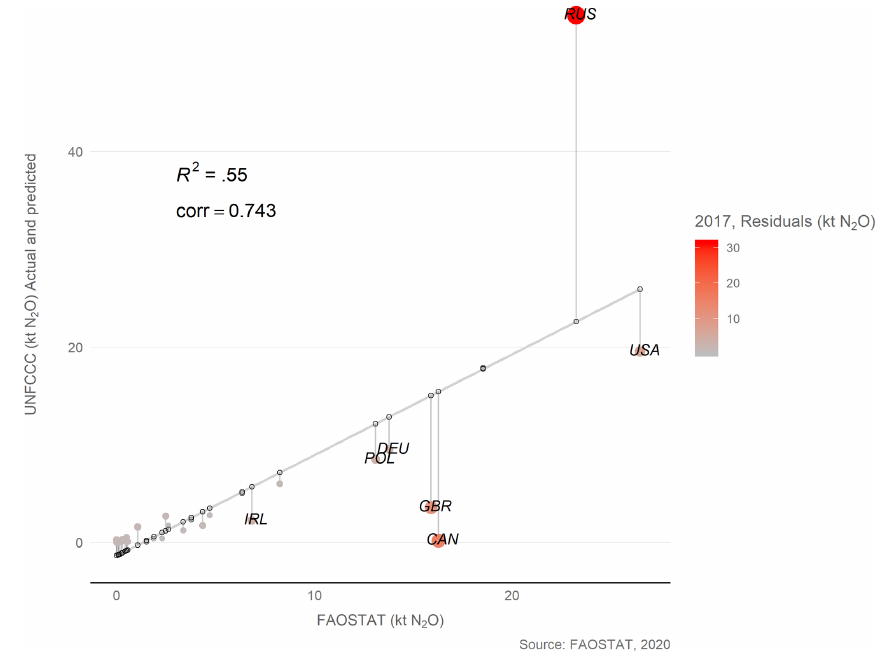
Figure 11. Comparison of FAOSTAT estimates of GHG emissions (N 2 O) compared to UNFCCC data (year 2017).